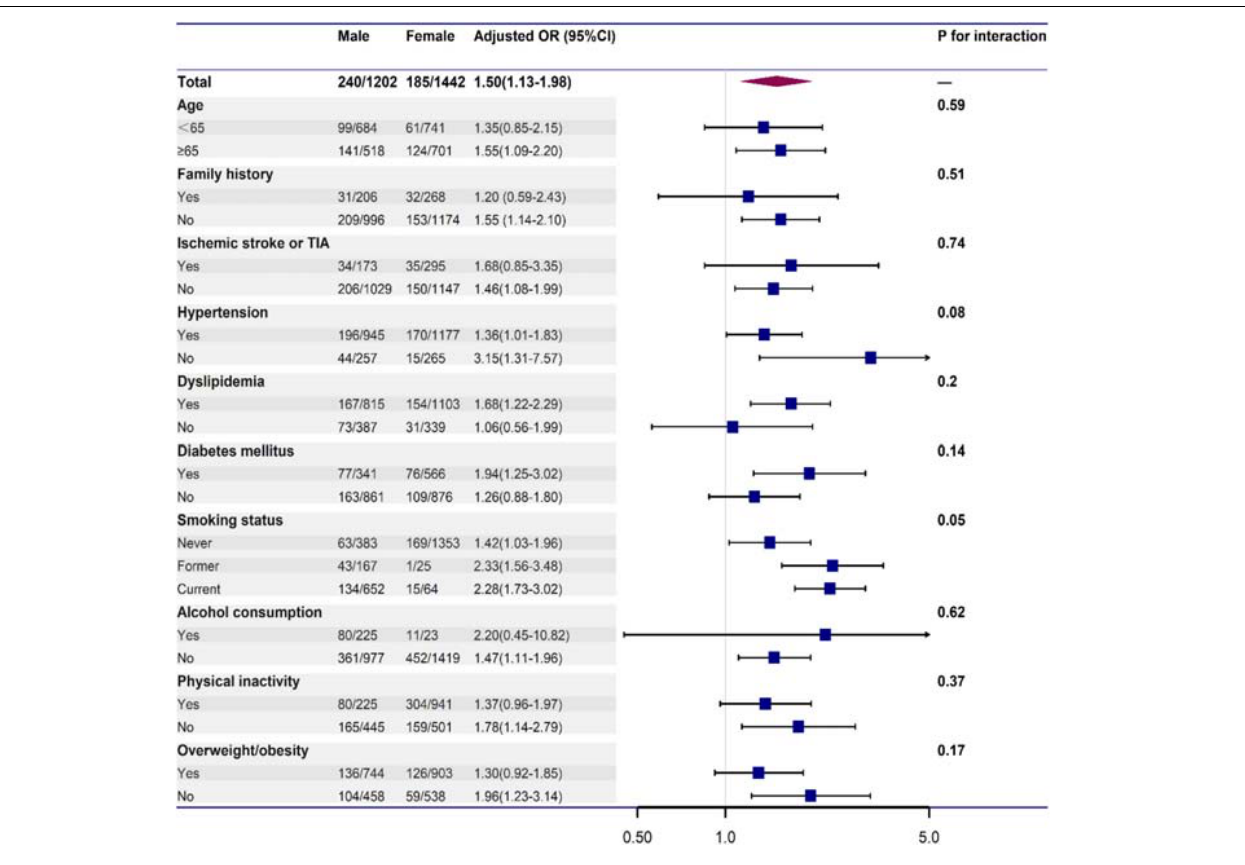
FIGURE 2 | Stratified logistic regression analysis to identify variables that modify the association between male and vulnerable carotid plaque. Each stratification was adjusted for age, family history of stroke, histories of chronic disease (ischemic stroke or TIA, hypertension, dyslipidemia, diabetes mellitus), smoking status, regular alcohol consumption, physical inactivity, and BMI, except for the stratification factor